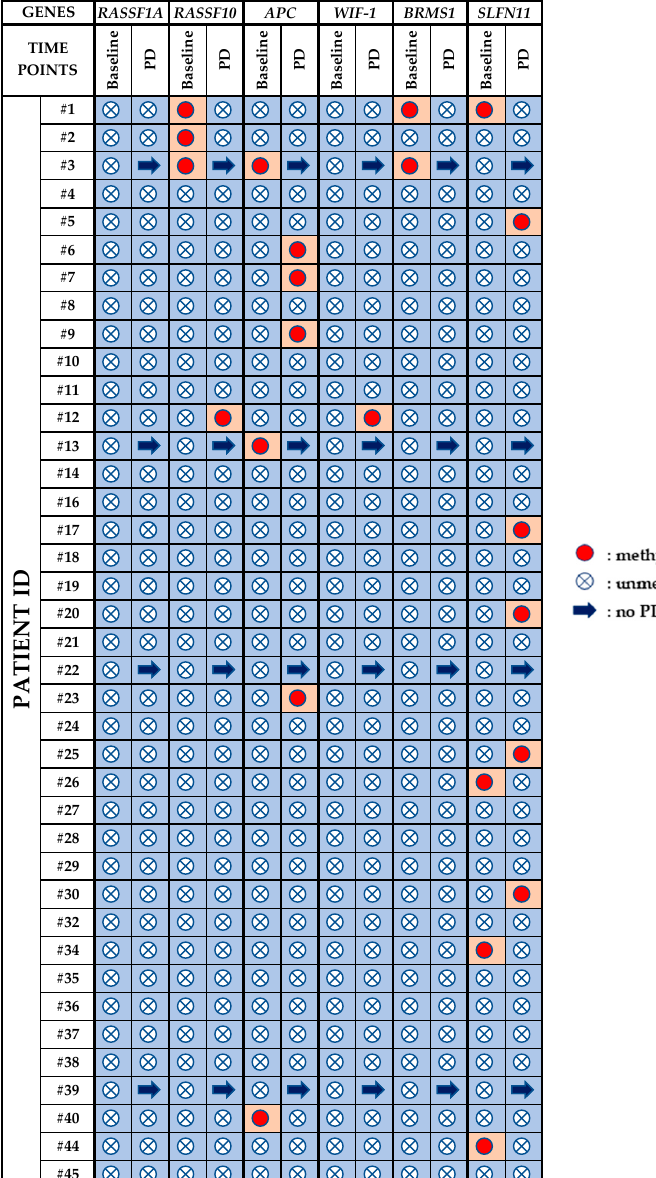
We evaluated in total 70 matched plasma ‐ cfDNA and CTC samples, 36 at baseline and 34 at PD for the methylation of six genes ( RASSF1A , RASSF10 , APC , WIF ‐ 1 , BRMS1 , SLFN11 ). At baseline, there was no agreement between plasma ‐ cfDNA and CTCs in terms of methylation, whereas at PD there was an agreement in patient #5 for SLFN11 , patients #6 and #9 for APC and patient #12 for WIF ‐ 1 . Totally different methylation patterns were